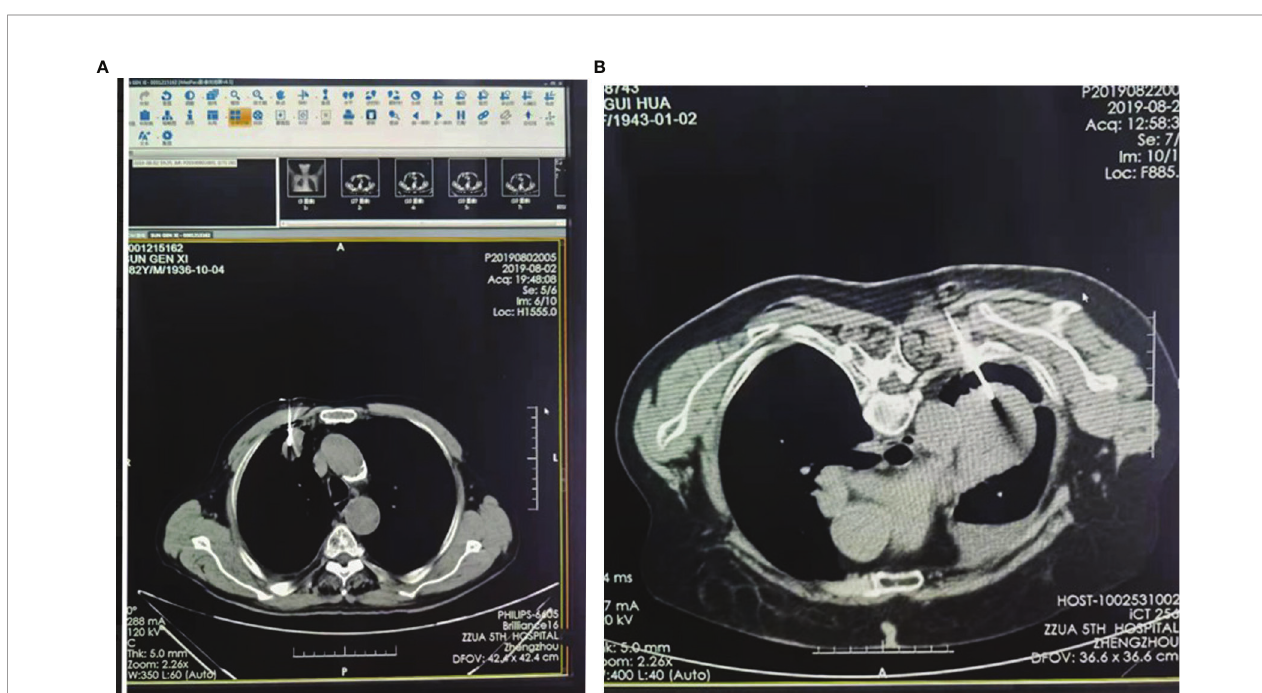
FIGURE 2 | Two case of CT-guided lung puncture. (A) Lesion diameter of 2-5 cm; (B) Lesion diameter